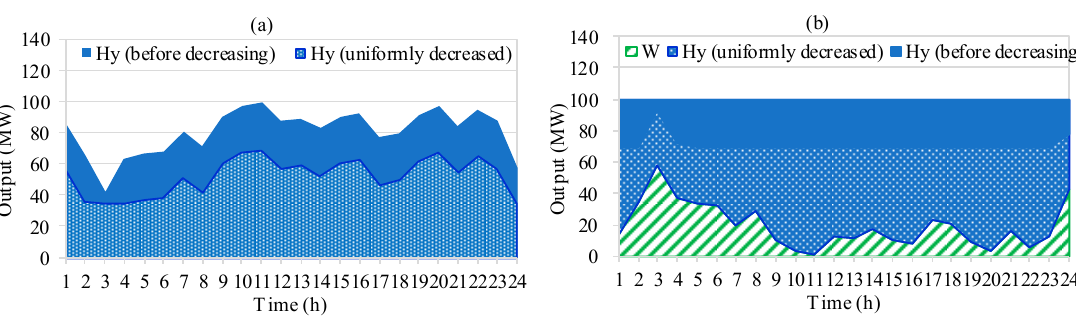
Figure 1. Reciprocal output processes of hydropower and wind/PV power. W refers to wind power, Hy refers to hydropower, and PV refers to PV power. The value of the combined output from hydropower, wind, and PV power, 100 MW, is an example value and could be replaced by other values. It is assumed that the flat (i.e., smoothest) combined output process of hydropower and wind/PV power is the ideal combined output. In addition, in a power system possessing only hydropower and wind/PV power, the ideal combined power output is equal to the power consumption.